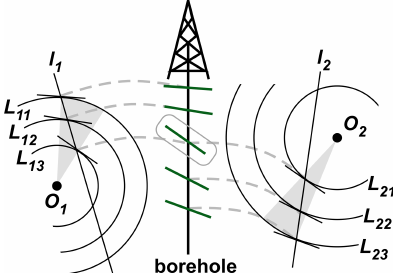
Figure 3. Schematic diagram of the procedure for creating a sim- ulated fold model. The grey hatch in the figure represents a fold created based on an arbitrary point O , and the green lines are the stratigraphic surface projected onto the